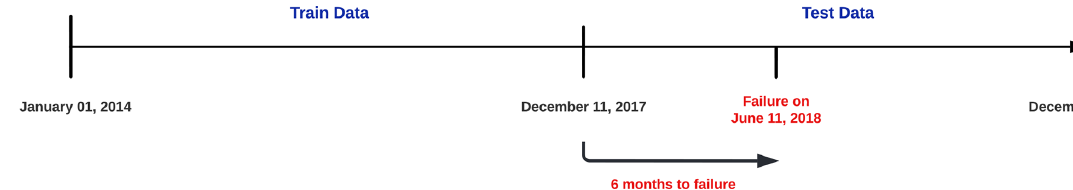
Figure 2. Data splitting for model training and testing.